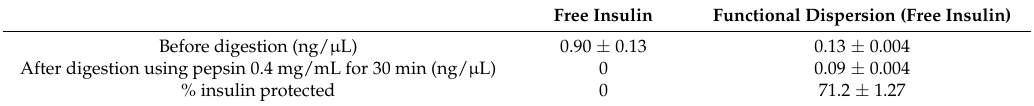
Table 1. The UV-Vis spectroscopy determination of the amount of free insulin protected by functional dispersion from pepsin digestion assay. Data are presented as the average of duplicates ± standard